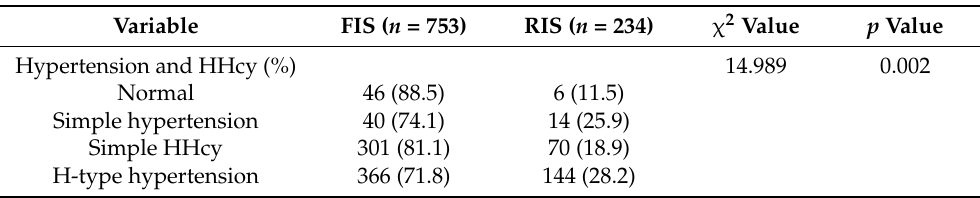
Table 2. Comparison of hypertension and hypertension with high homocysteine (HHcy) between FIS and RIS groups.